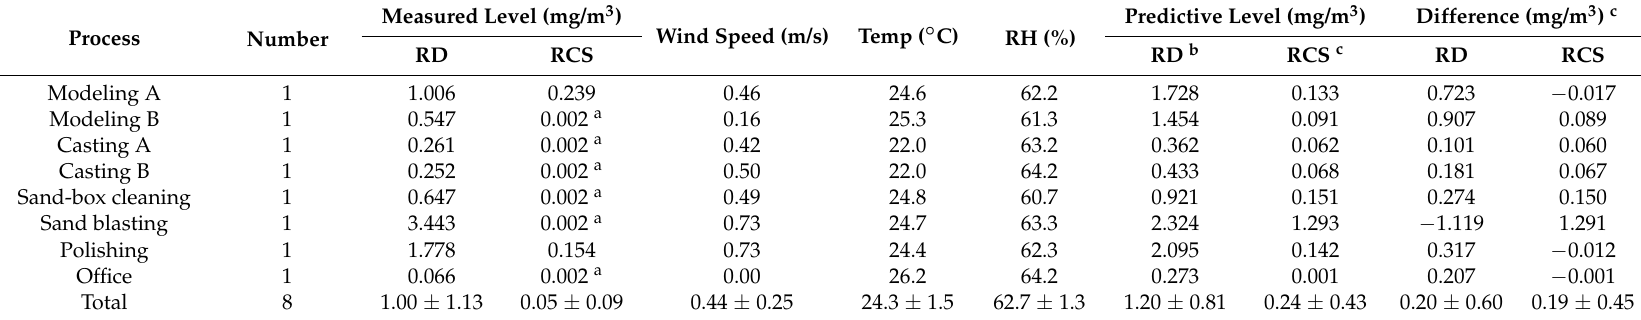
Table 5. Differences between predictive and measured levels of respirable dust and respirable crystalline silica, for different processes.